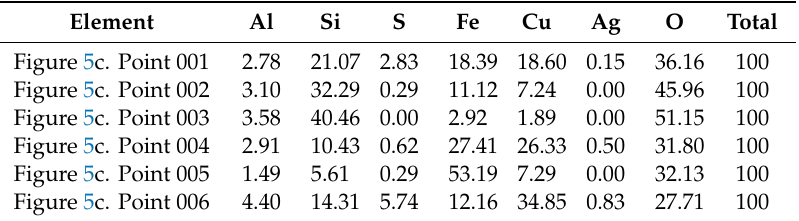
Figure 5c. Point